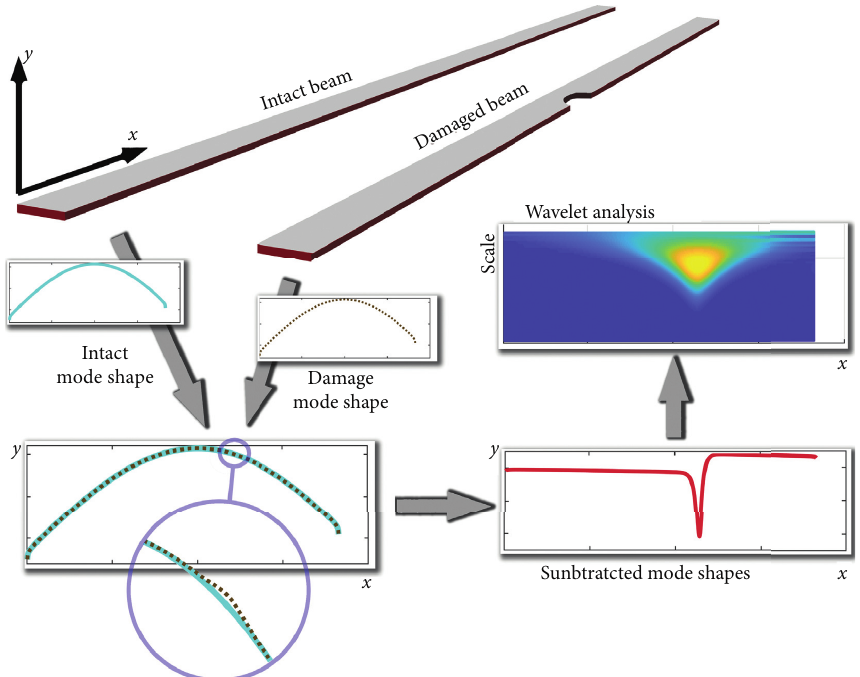
Figure 3: Scheme of localization procedure based on modal filtration.